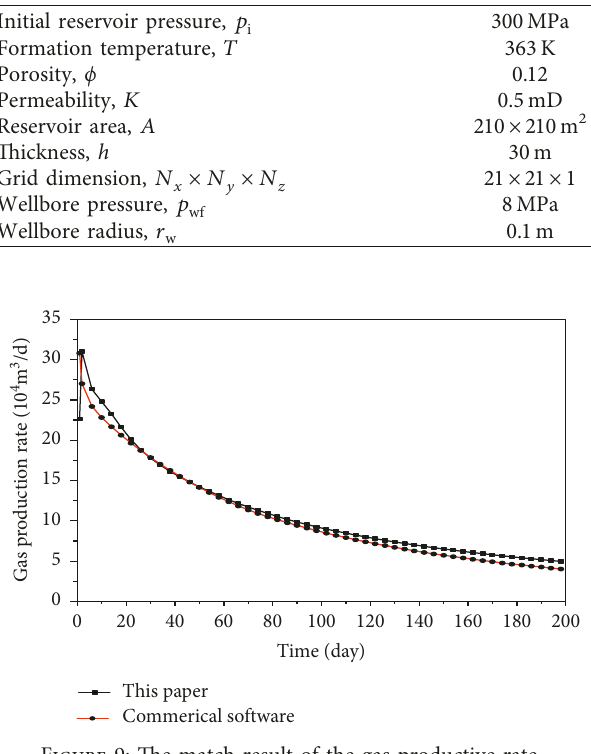
Figure 9: The match result of the gas productive rate.